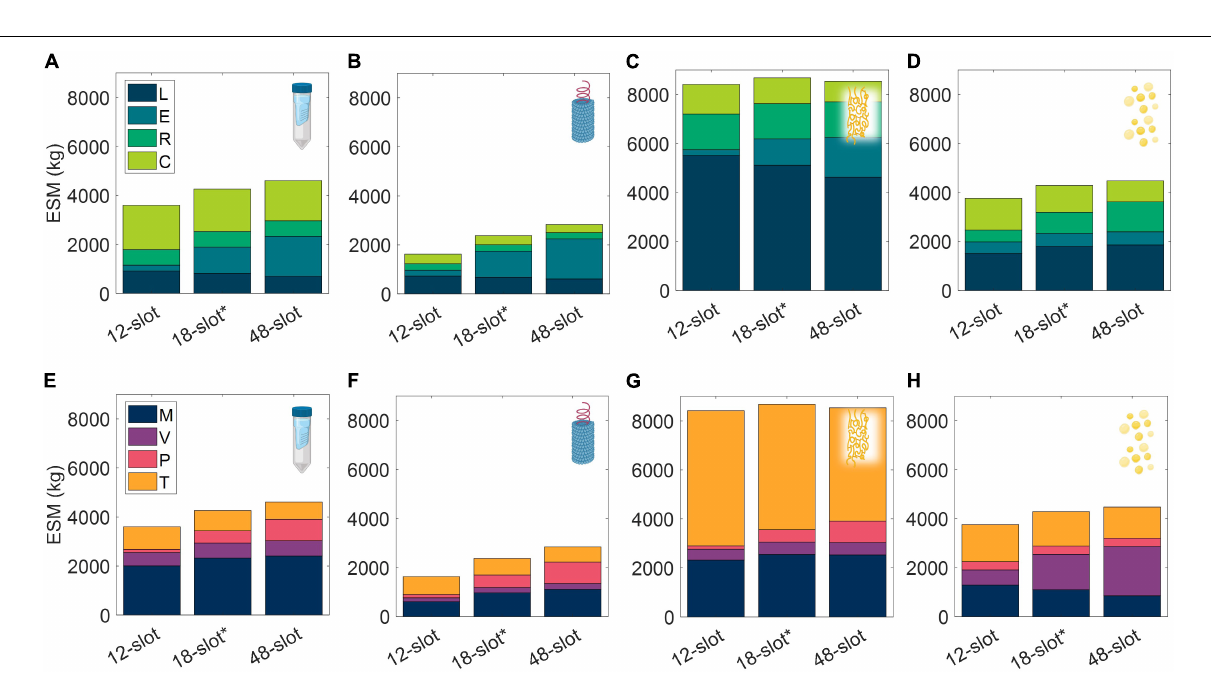
Frontiers in Microbiology |